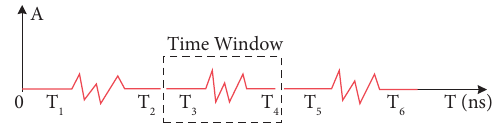
Figure 3: Schematic diagram of time window selection.